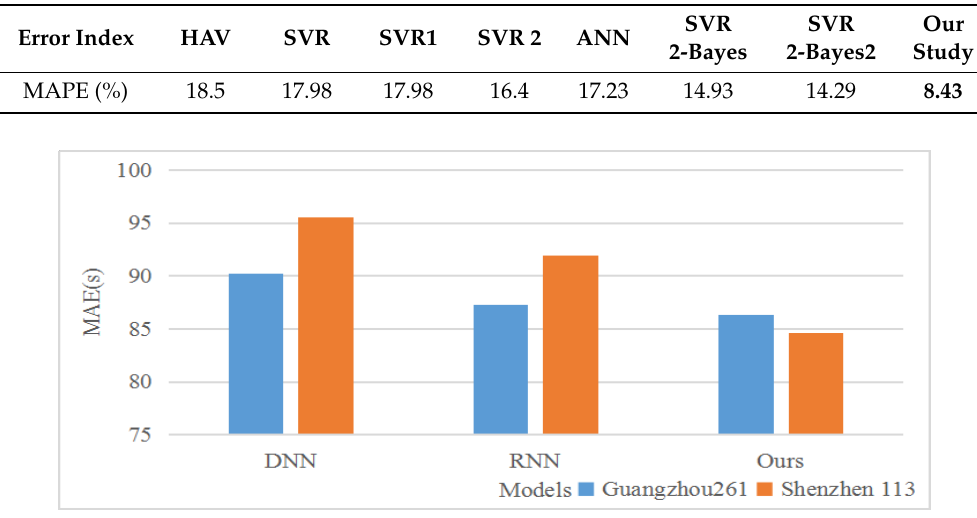
Figure 7. Comparison of different datasets